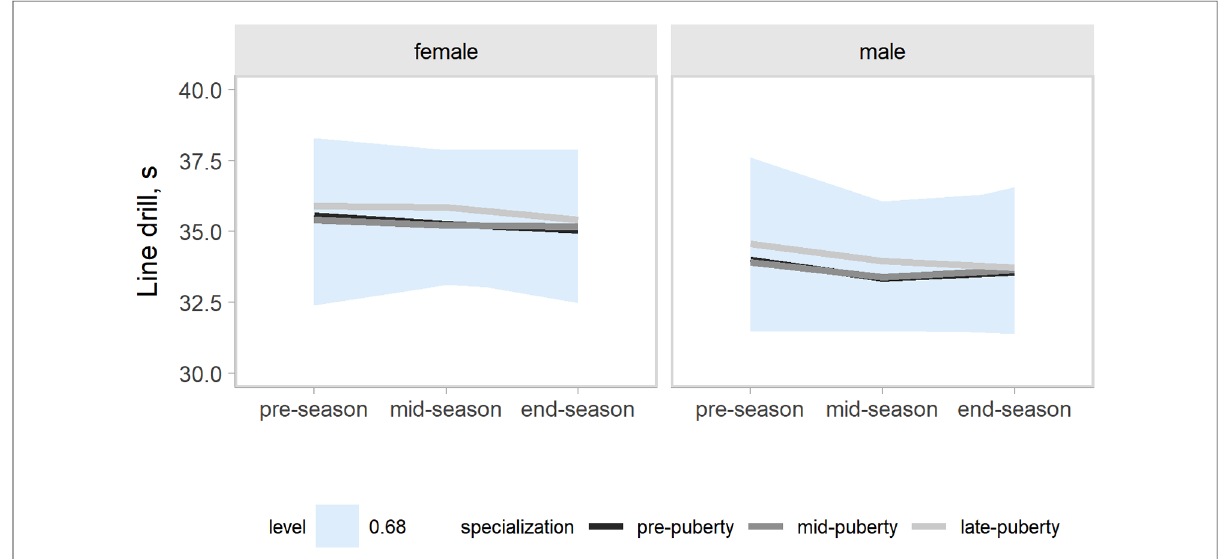
FIGURE 2 Changes in line-drill performance for young females and male basketball players within a basketball season by the onset of specialization. The shaded area represents the 68% credible interval, similar to a standard